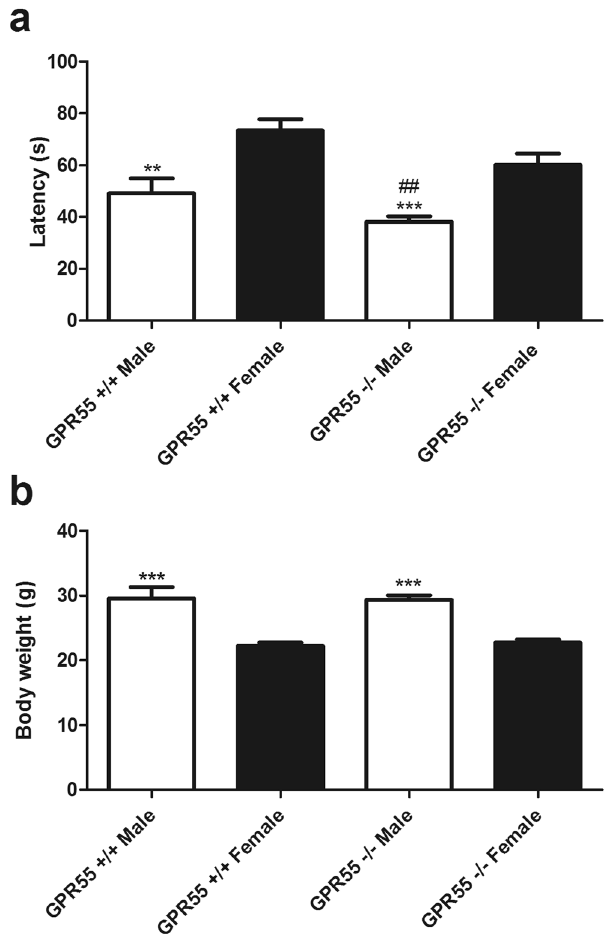
Figure 1. Male mice show decreases in rotarod performance. Male GPR55 KO and WT mice display decreased latencies to descent relative to female GPR55 KO and WT mice, ( a ). Data are expressed as mean ± SEM (n = 9–15 per group). Two-way ANOVA, 2-tailed t-test with Welch’s correction. *** p < 0.001, ** p < 0.01vs. female WT, ## p < 0.01 vs. female GPR55 KO. Male mice display higher body weights relative to female mice irrespective of genotype ( b ). Data are expressed as mean ± SEM (n = 9–15 per group). Two-way ANOVA, two- tailed t